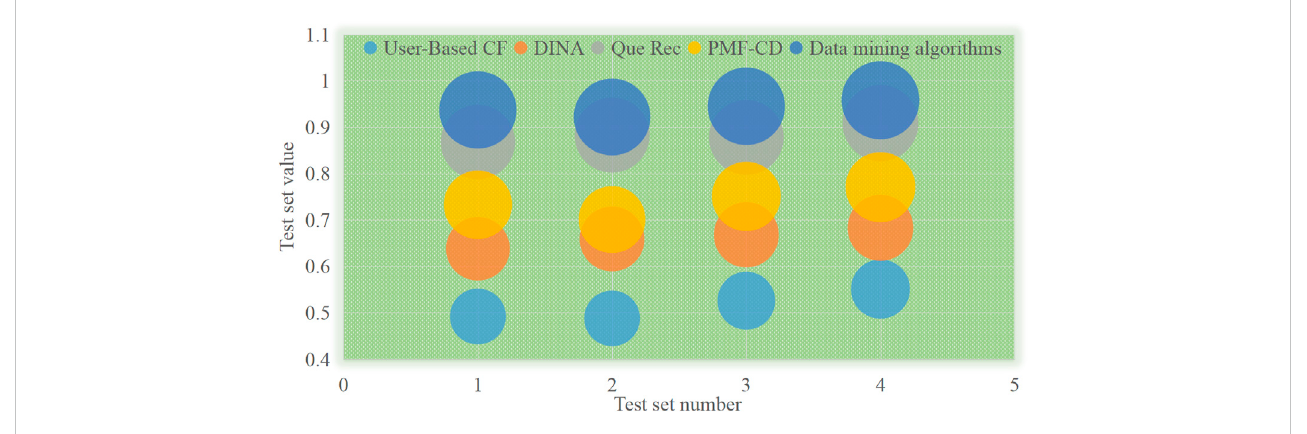
FIGURE 9 P1 value of complex stock market resource